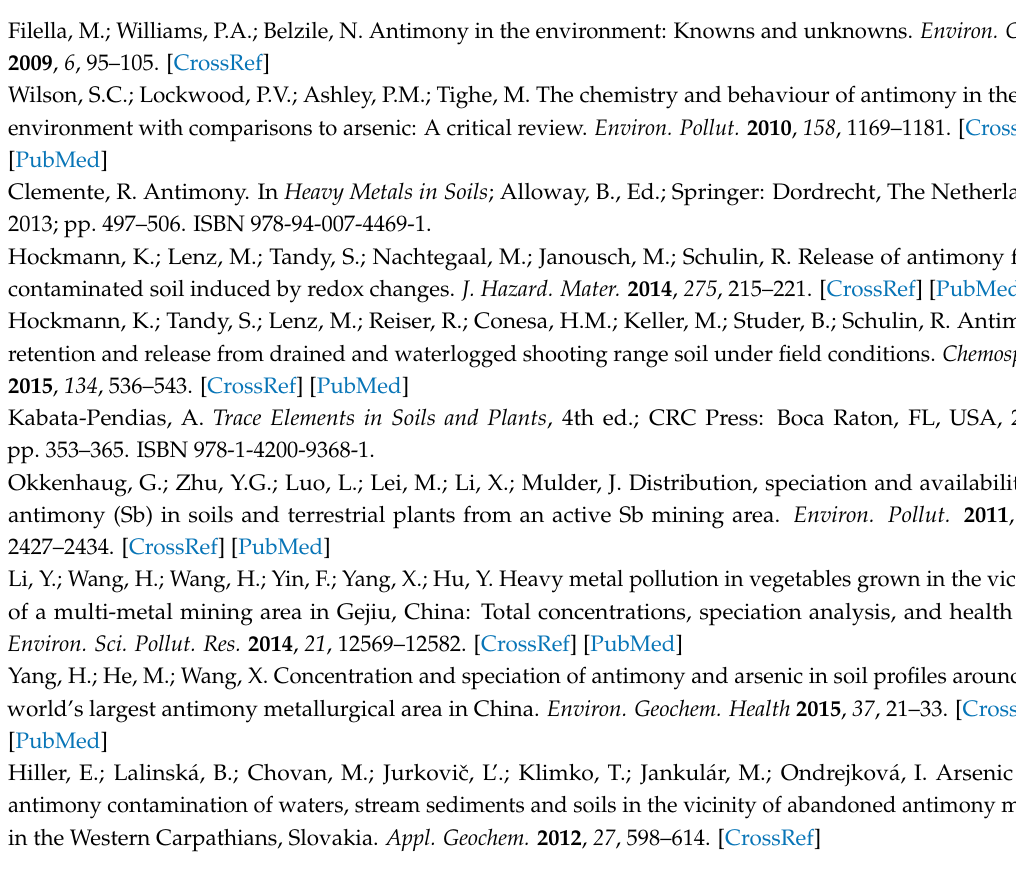
Table S1: The values of Eh and pH of soil pore water collected after 2, 7, 14, 28 and 90 days of incubation. Author Contributions: A.K. and K.L. conceived and designed the experiments. K.L., B.G., and M.S. performed the analysis and contributed reagents, materials, and analysis tools. A.K. and K.L. analysed data and wrote the paper. All authors have read and approved the final manuscript. Funding: This research was supported by National Science Centre of Poland, project No. 2014/13/B/ST10/02978. Conflicts of Interest: The authors declare no conflict of